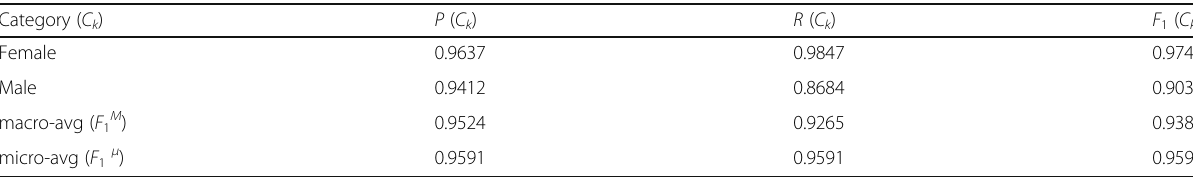
Table 7 Results with norm-TF with cross validation = 5